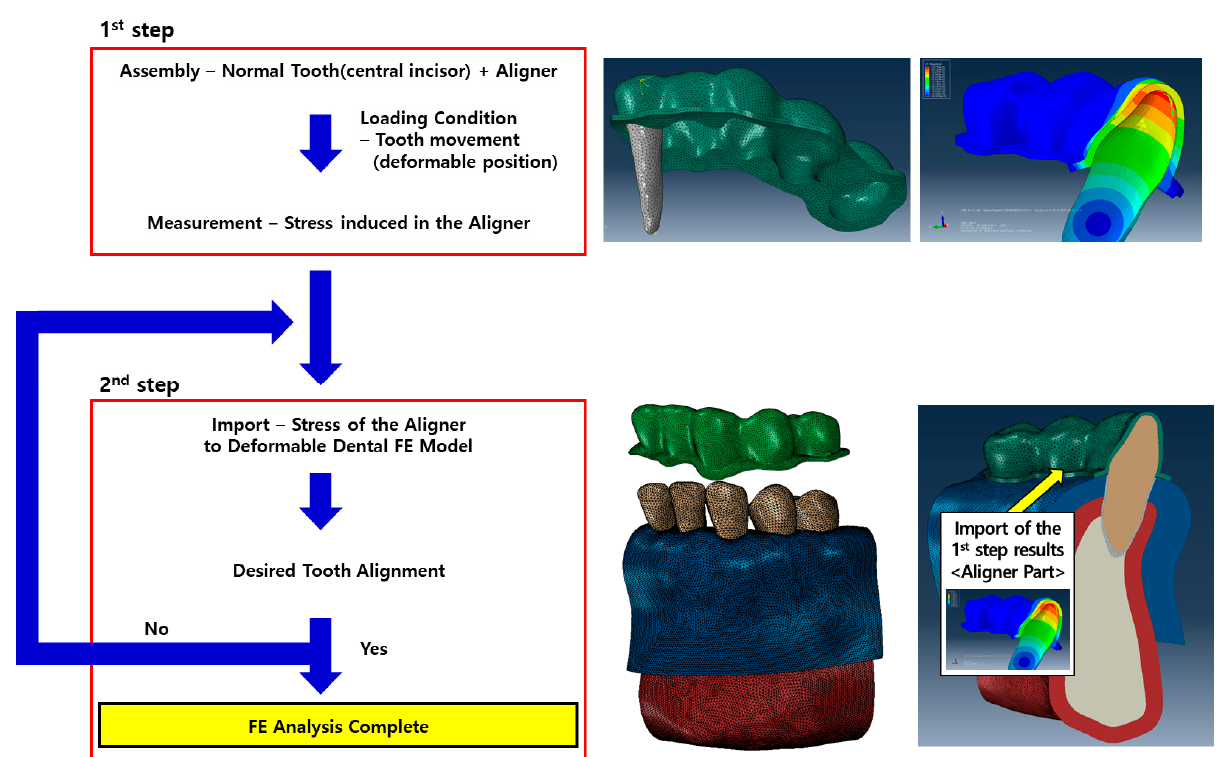
Figure 4. Process of the FEA in orthodontic treatment using the clear aligner.